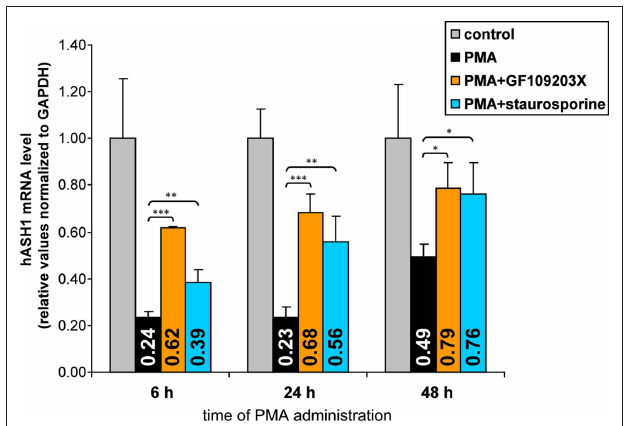
Figure 6 | influence of PKC inhibition on PMA-mediated hASH1 suppression. Kelly cells were pre-incubated for 4 h with the PKC inhibitors GF109203X or staurosporine to block PKC activity. Then, PMA was supplemented and cells were harvested after 6, 24, and 48 h of PMA administration. hASH1 mRNA levels were estimated by qPCR and normalized to the influence of inhibitors alone (see Figure A2 in Appendix for time kinetic of PKC inhibitors). n = 9; * p < 0.05, ** p < 0.01, *** p < 0.001.